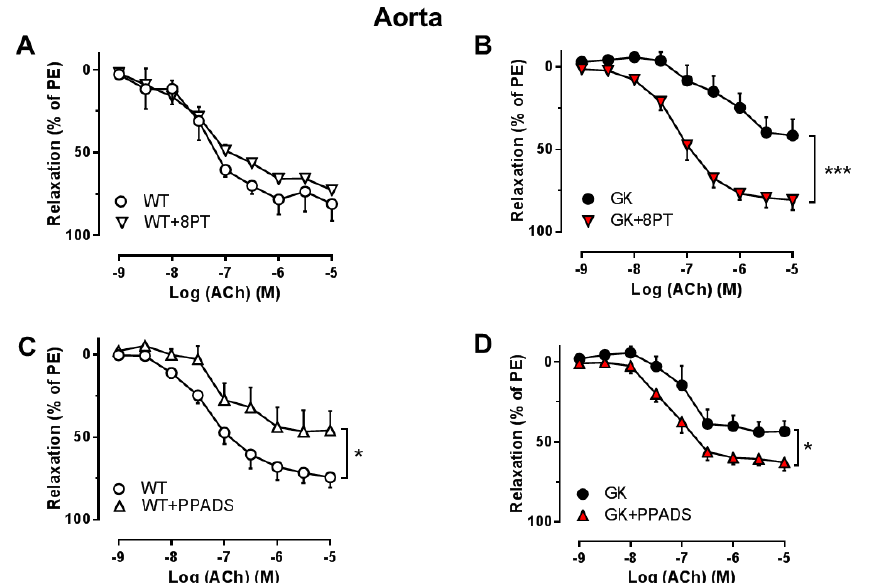
Figure 2. Effects of the P1R and P2R antagonists on EDR in aortas from WT and GK rats. Concentration-response curves for acetylcholine (ACh) in aortas preconstricted with PE in the absence and presence of the non-selective P1R antagonist (8PT, 10 − 5 M) from WT ( A , n = 3) or GK ( B , n = 6). Concentration-response curves for ACh in aortas preconstricted with PE in the absence and presence of the non-selective P2R antagonist (PPADS, 10 − 5 M) from WT ( C , n = 5) or GK ( D , n = 5). Data are presented as mean ± SEM as percentage relaxation of PE. * p < 0.05, *** p < 0.001, calculated with two-way ANOVA.